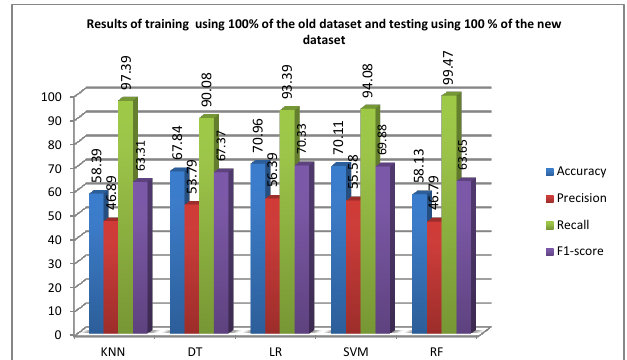
Figure 8. The performance of supervised machine learning algorithms trained on 100% of the new dataset and tested on 100% of the old dataset.